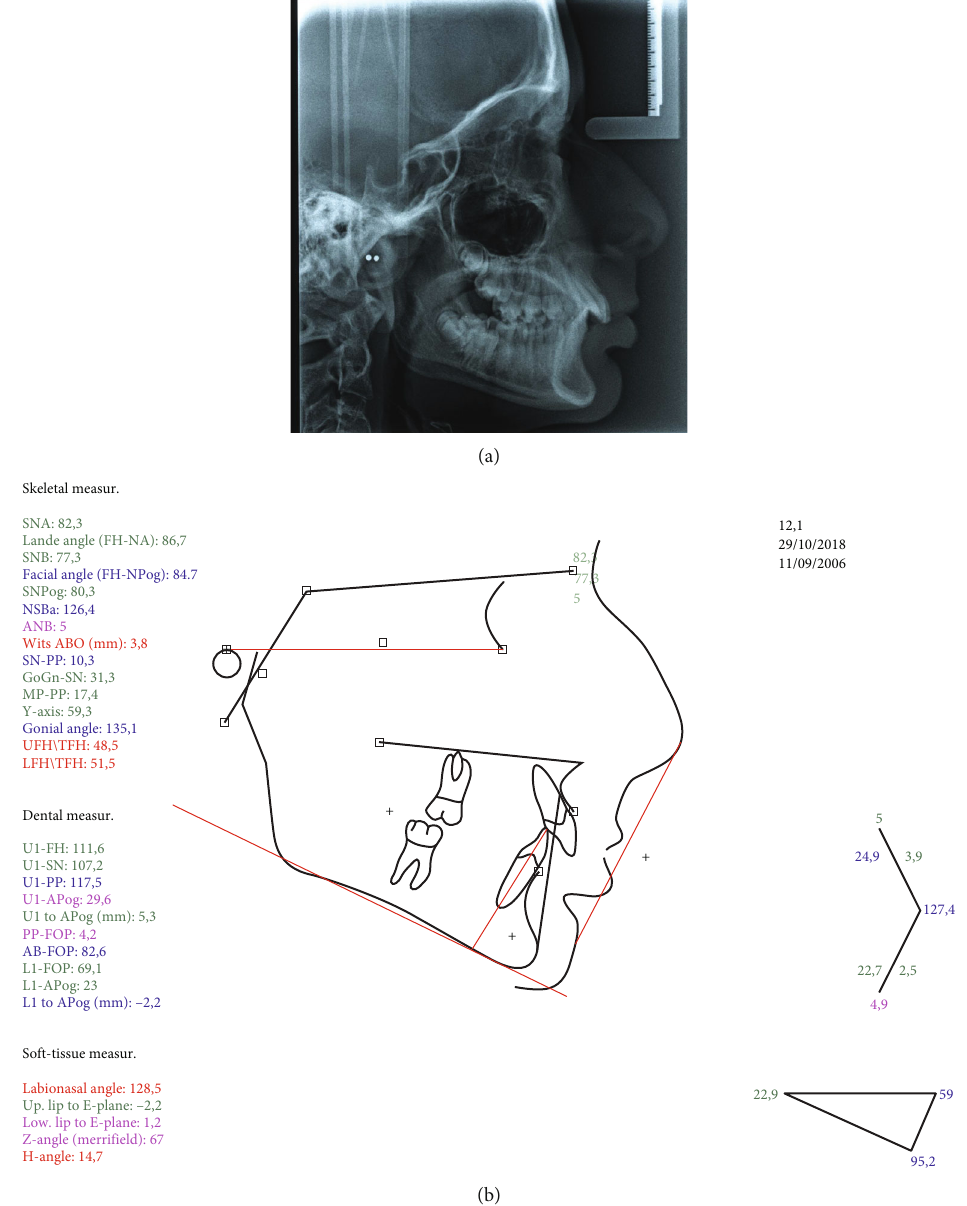
Figure 2: Pretreatment (a) lateral cephalogram and (b) tracing.